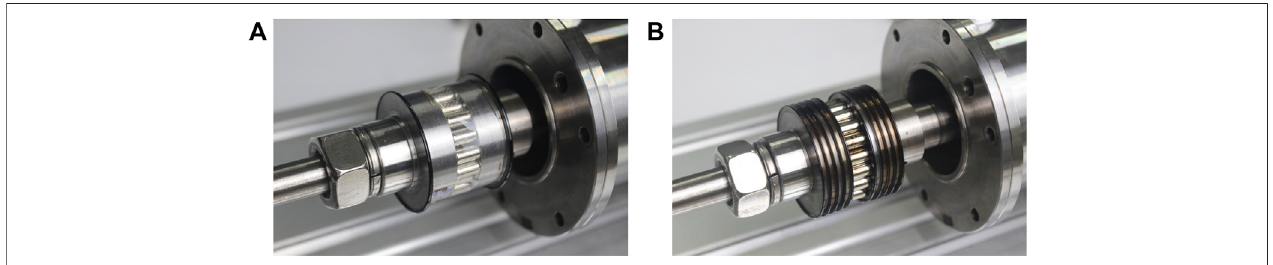
FIGURE 7 | Magnetic fl uid injection on pole teeth. (A) One pole tooth and (B) fi ve pole teeth per pole piece.